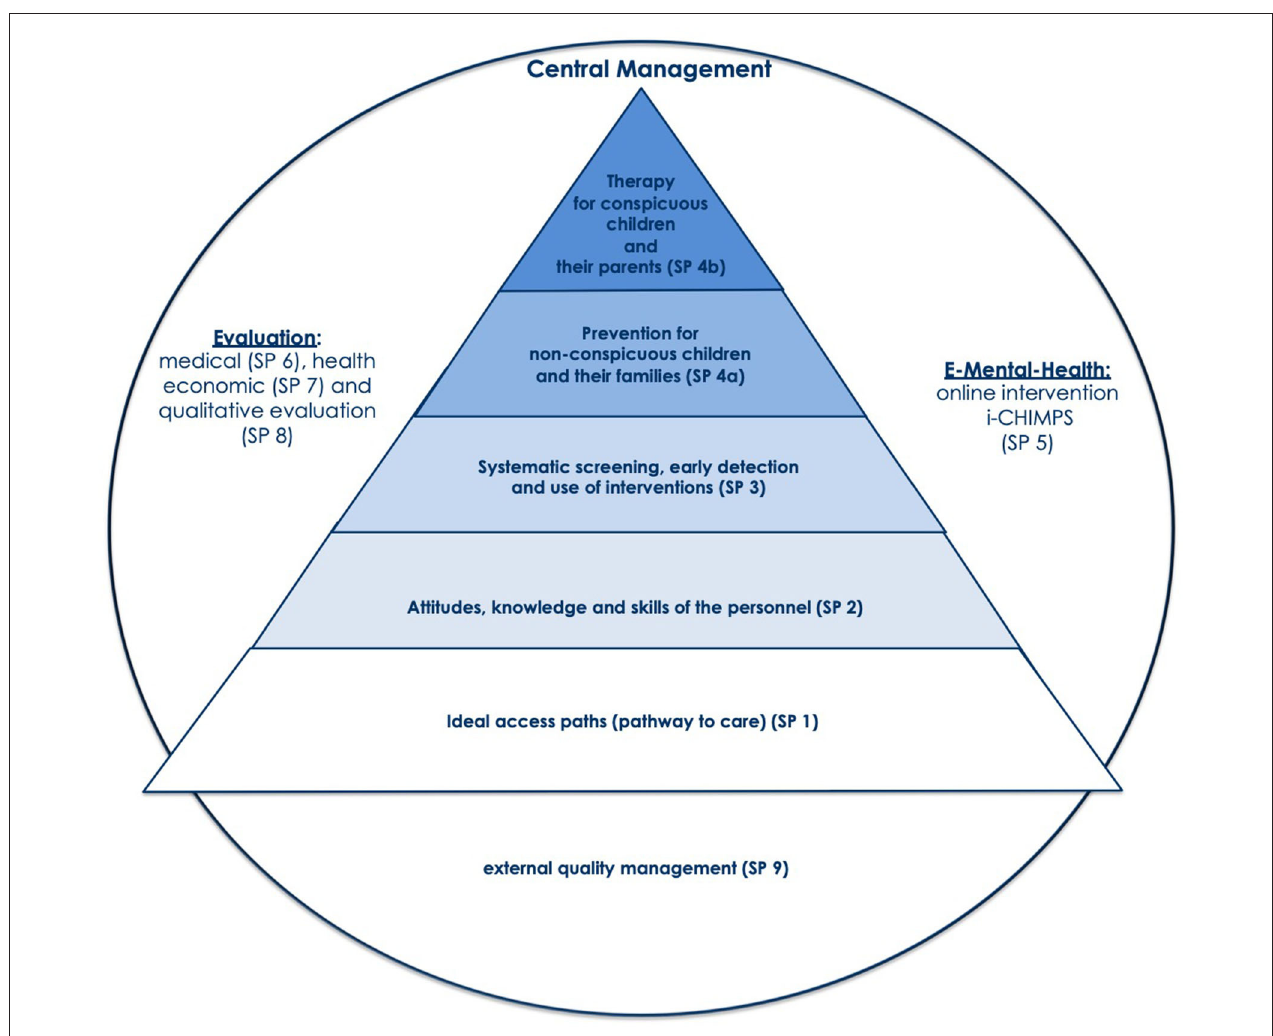
FIGURE 1 | The CHIMPS-NET Implementation Model [based on (22) and first published (25)] for the health care for children and their mentally ill parents.